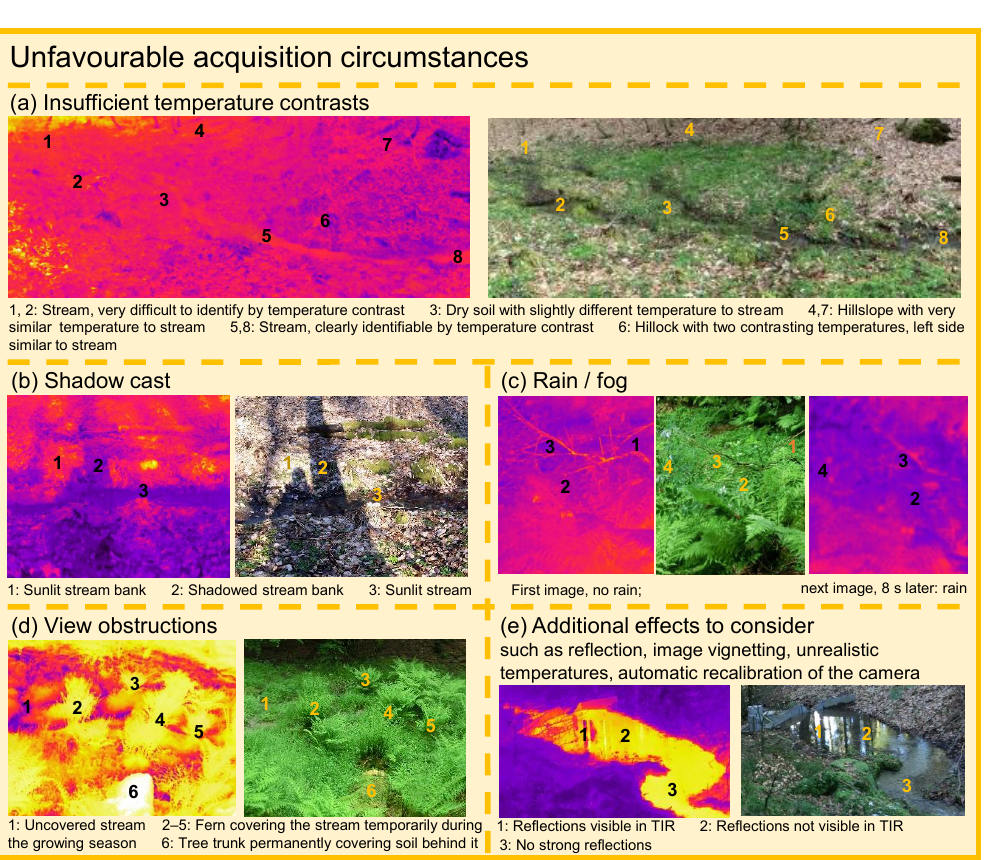
Figure 2. Example images showing how unfavourable image acquisition circumstances influence the usability of TIR imagery for the identification of surface saturation. The numbers indicate identical locations in the TIR and VIS